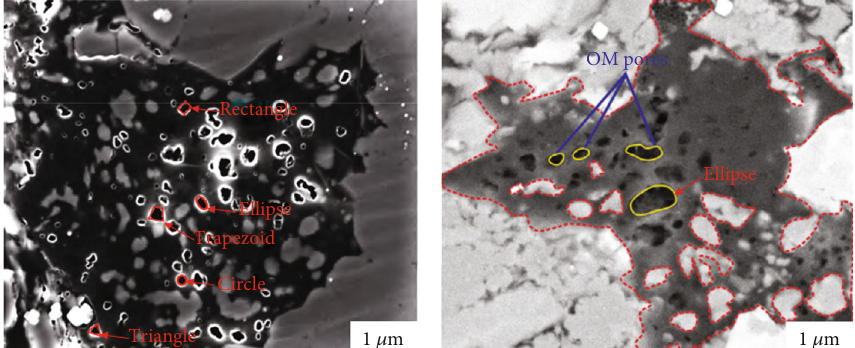
Figure 5: SEM photos of nanopores in typical organic matter of well Wuxi 2